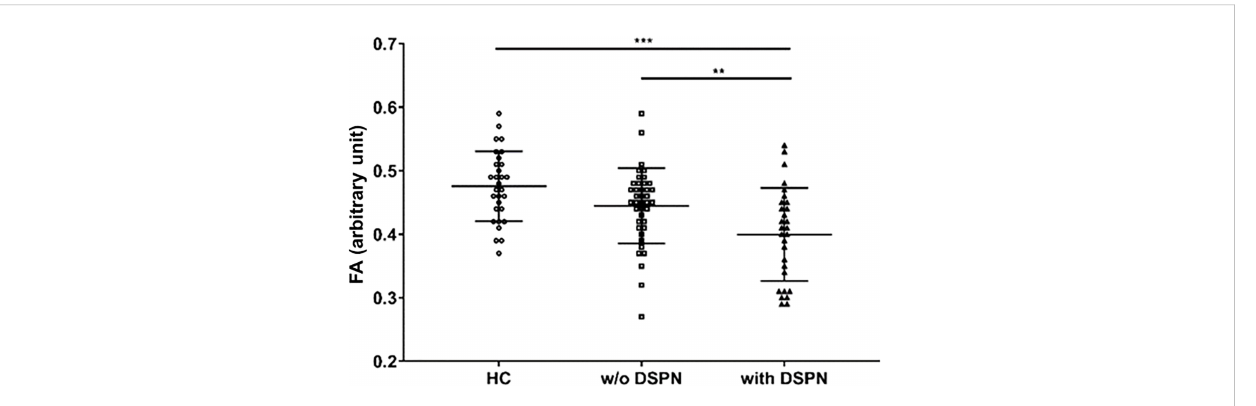
FIGURE 1 Quanti fi cation of sciatic nerve ’ s fractional anisotropy in control participants (n=30), participants with type 2 diabetes without DSPN (n=40), and participants with type 2 diabetes and DSPN (n=29). FA, fractional anisotropy; HC, healthy control; DSPN, Diabetic sensorimotor polyneuropathy. **p<0.01; ***p<0.001.